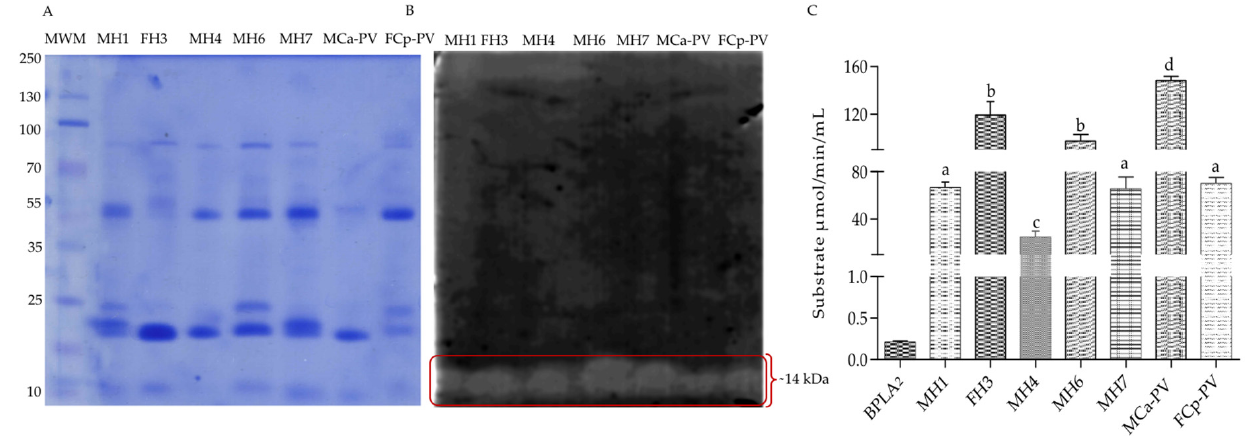
Figure 7. Snake venom phospholipase A 2 activity. ( A ) 10% SDS-PAGE using 100 ng of venom protein. ( B ) Zymography on agarose gel copolymerized with egg yolk. ( C ) Enzymatic activity of 100 ng of venom protein. Hybrids of the first hybridization event (11 years old): MH1, FH3, and MH4; hybrids of the second hybridization event (10 years old): MH6 and MH7; pooled venom of MCa-PV and FCp-PV. The MWMs are to the left. Lowercase letters indicate significant statistical difference (Tukey; p < 0.05).